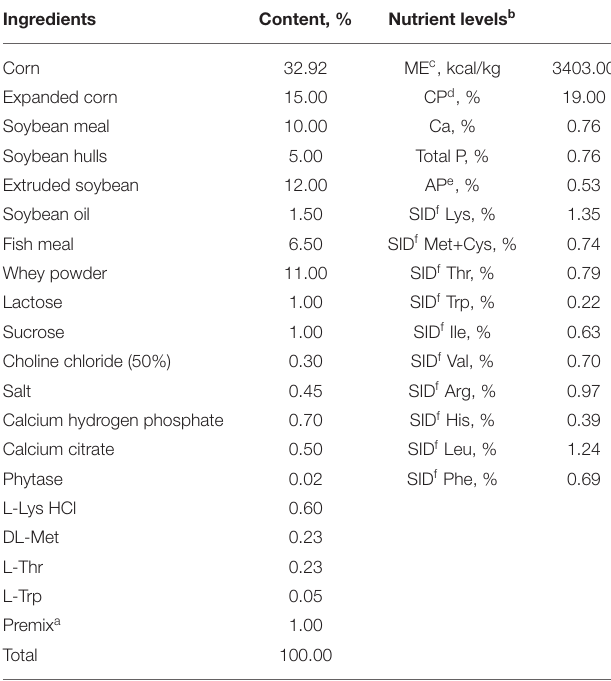
TABLE 1 | Ingredients and nutrient levels of basal diet (air-dry basis).